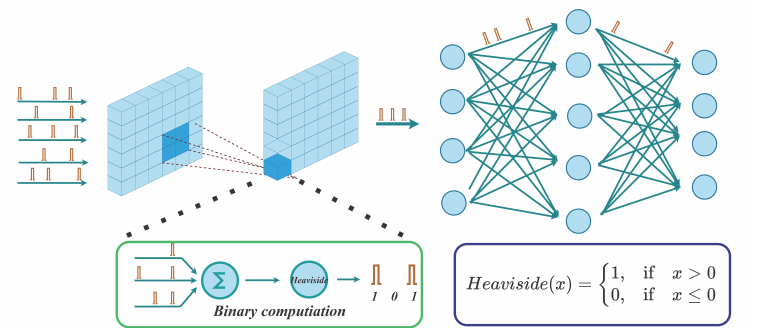
Figure 1. Information transfer and structure diagram of Deep SNNs. If the input type is a floating point, it is usually encoded as a spike train and injected into the network at different time steps. When the membrane potential exceeds a threshold, the spiking neurons can accumulate the spikes from the presynaptic neurons and fire; otherwise, the output is